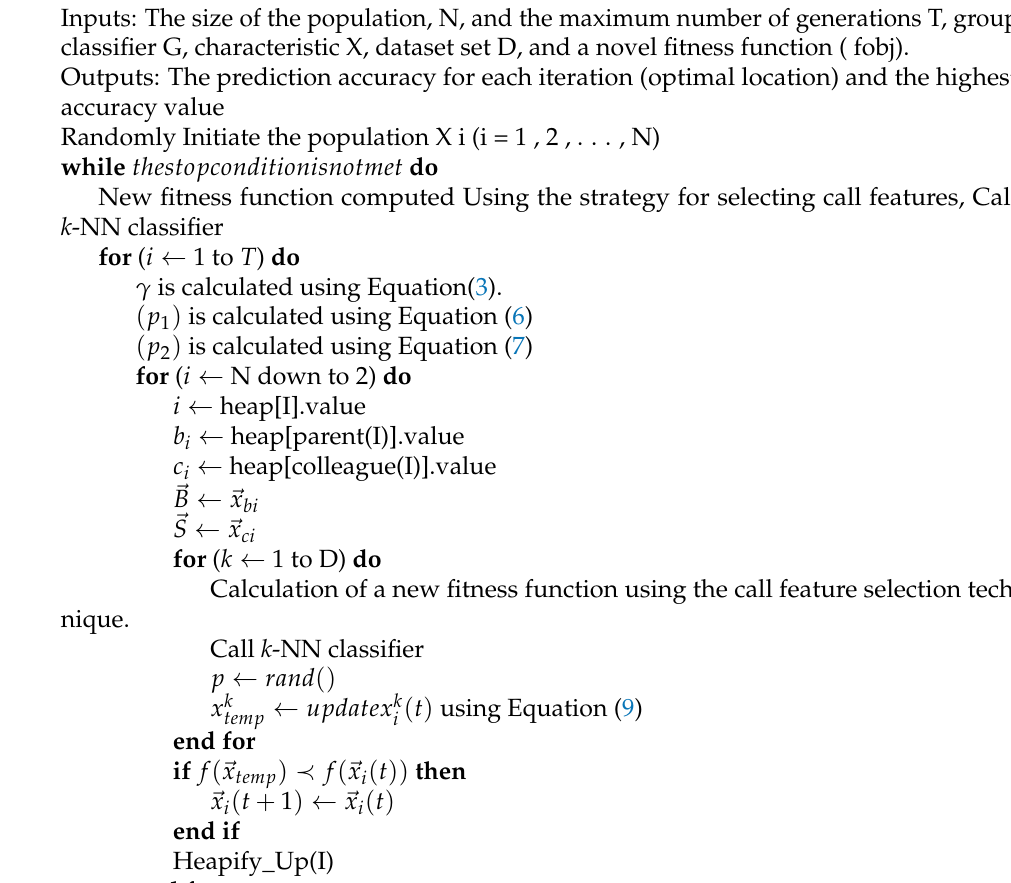
Algorithm 4 The Pseudo code of the proposed B _ HBO based on KNN